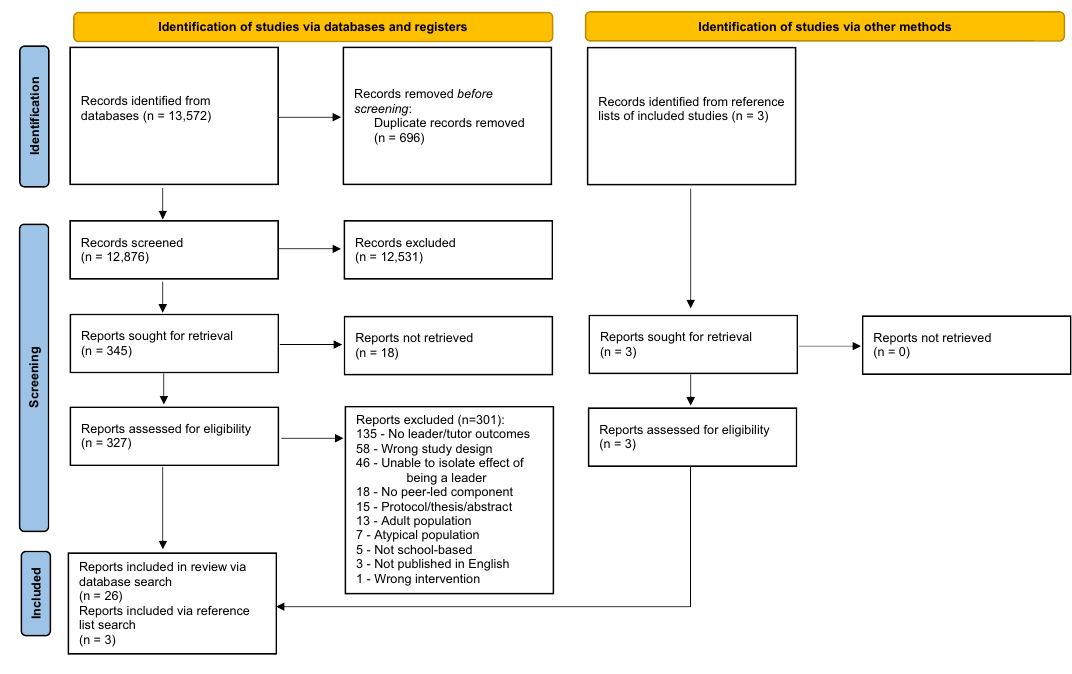
Figure 1. Flow of studies through the systematic review